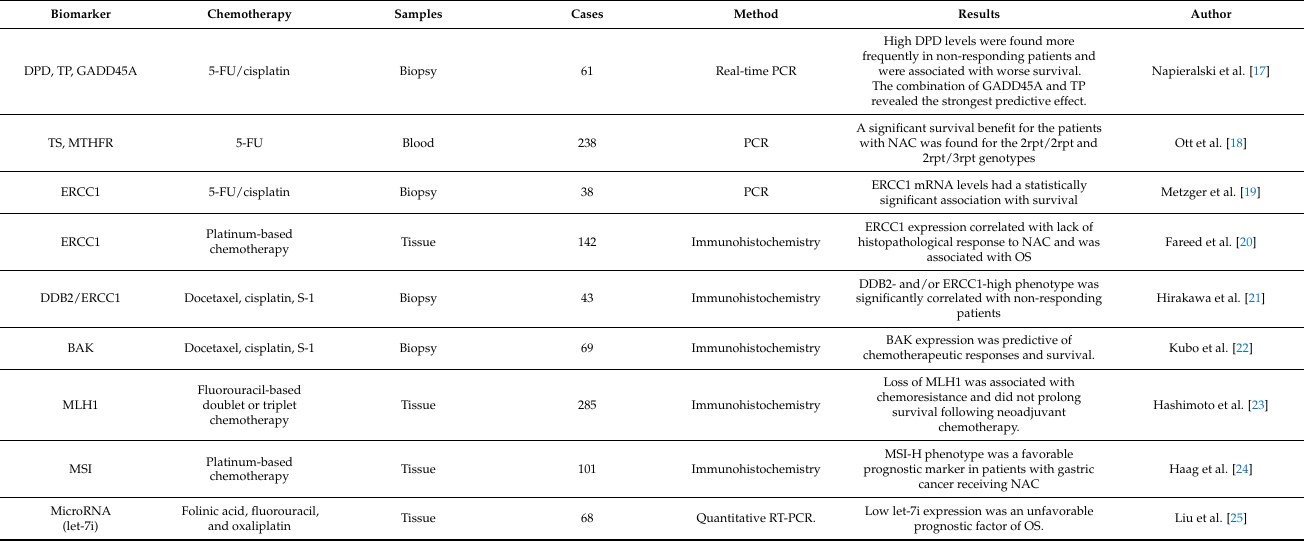
Table 2. Predictors of response to preoperative chemotherapy for advanced gastric